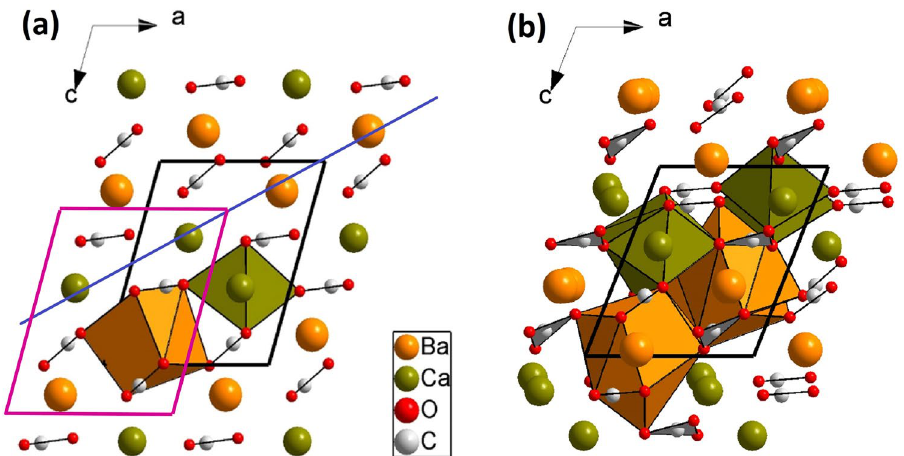
Figure 1. Structures of BaCa(CO 3 ) 2 P 2 1 / m barytocalcite (a) and high-pressure Pm post-barytocalcite (b) projected along the b crystallographic unitcell axis. Note that the b axis of the high-pressure phase is twice that of the low-pressure barytocalcite. Orange, green, light gray, and red spheres represent Ba, Ca, C and O atoms, respectively. Cell edges are depicted as solid black lines. Magenta solid lines on the barytocalcite projection demarcate the location of post-barytocalcite unit cell contents, for the sake of comparison between structures. The diagonal blue line indicates a hexagonal layer of metallic atoms.